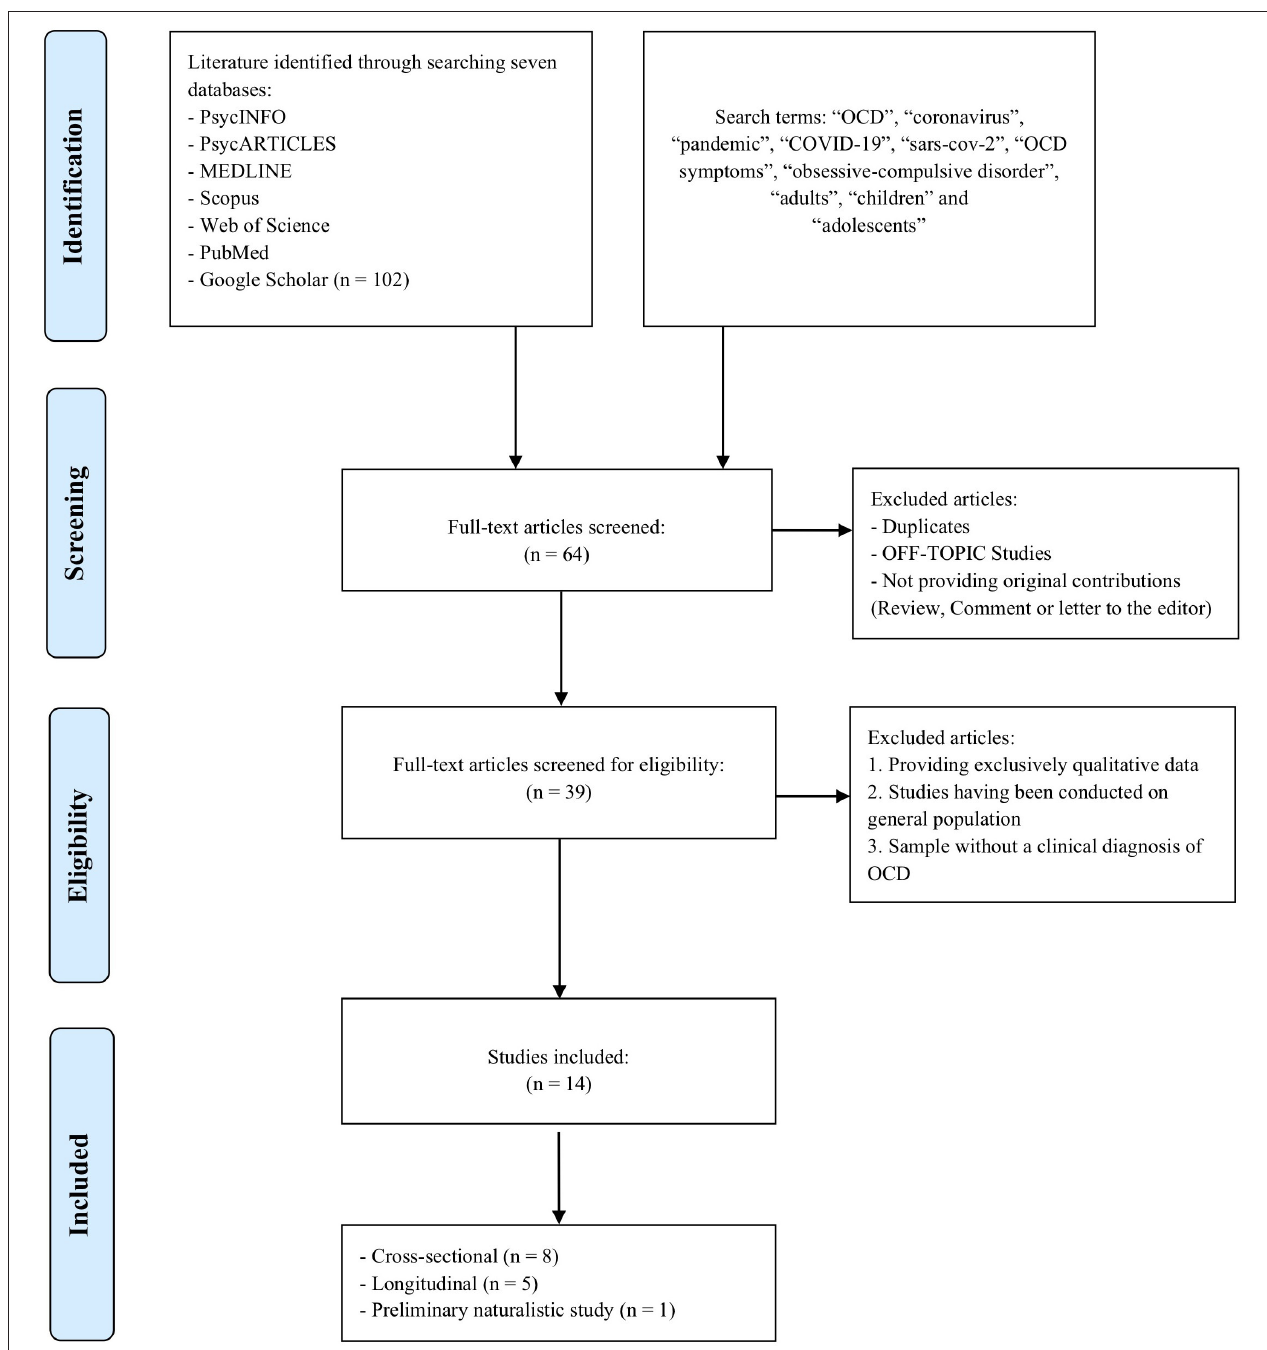
FIGURE 1 | Flowchart on search